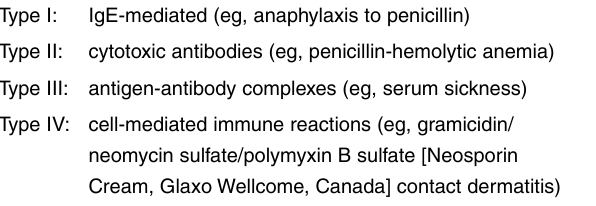
TABLE 1 Classification of allergic drug